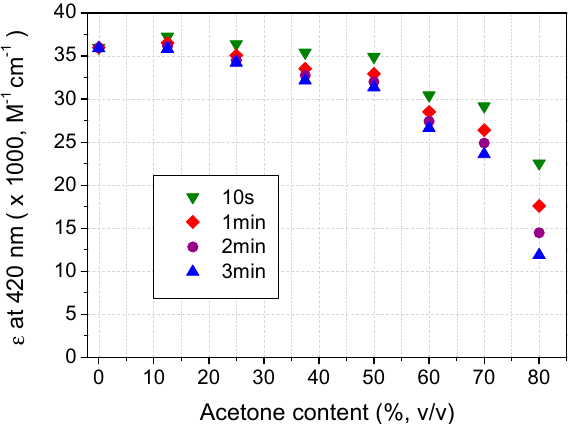
Figure 3. Effects of mixing time on ε of ABTS radicals in Aq/Ac media.